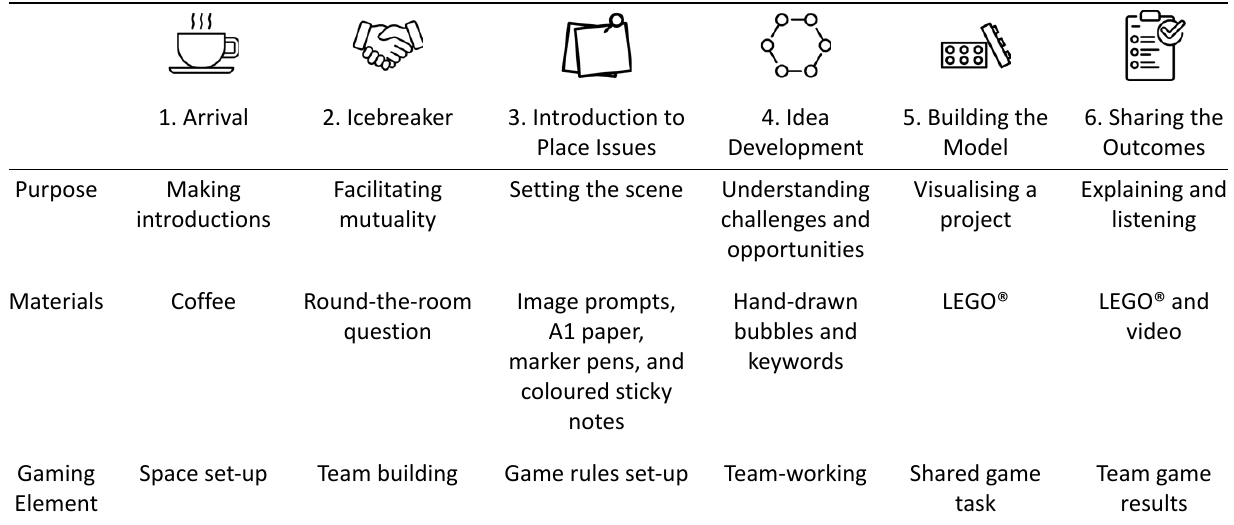
Table 1. Sequential stages of the LEGO® mash‐up